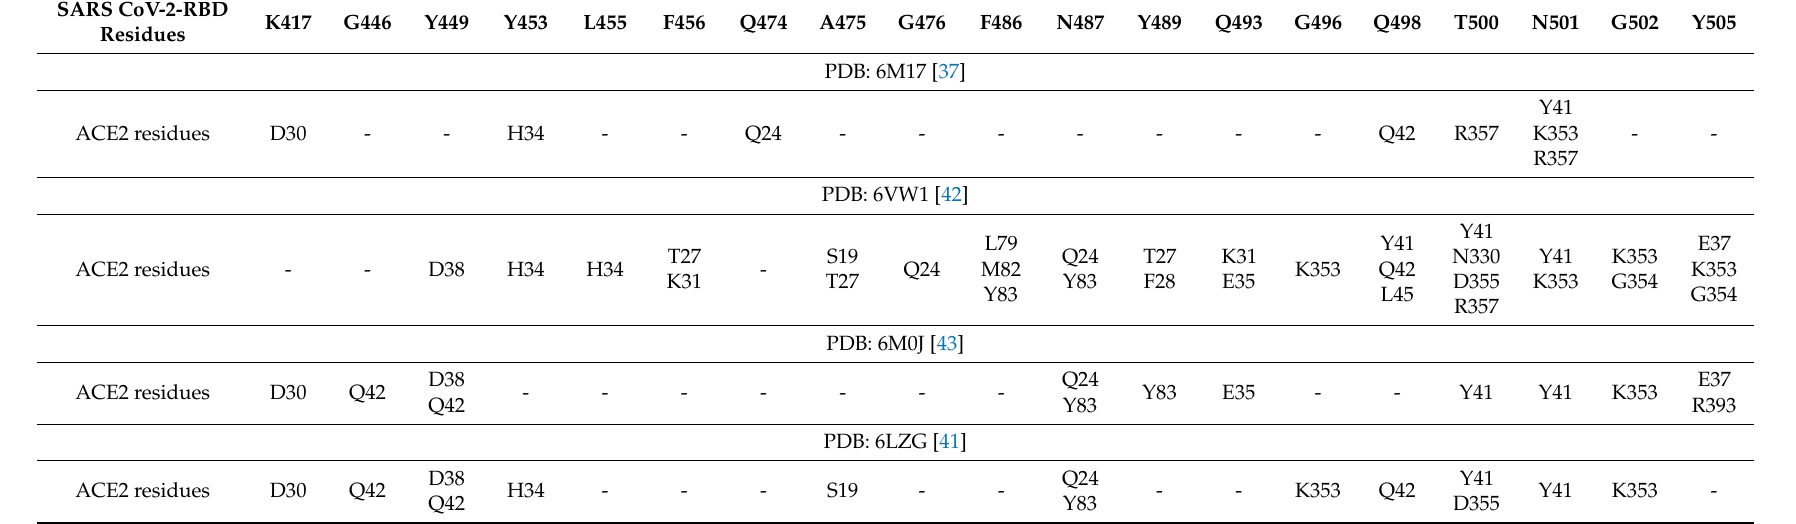
Table 1. The hydrogen bonds formed at the SARS CoV-2 RBD–ACE2 interfaces of PDBs 6VW1, 6M0J, 6M17 and 6LZG. SARS